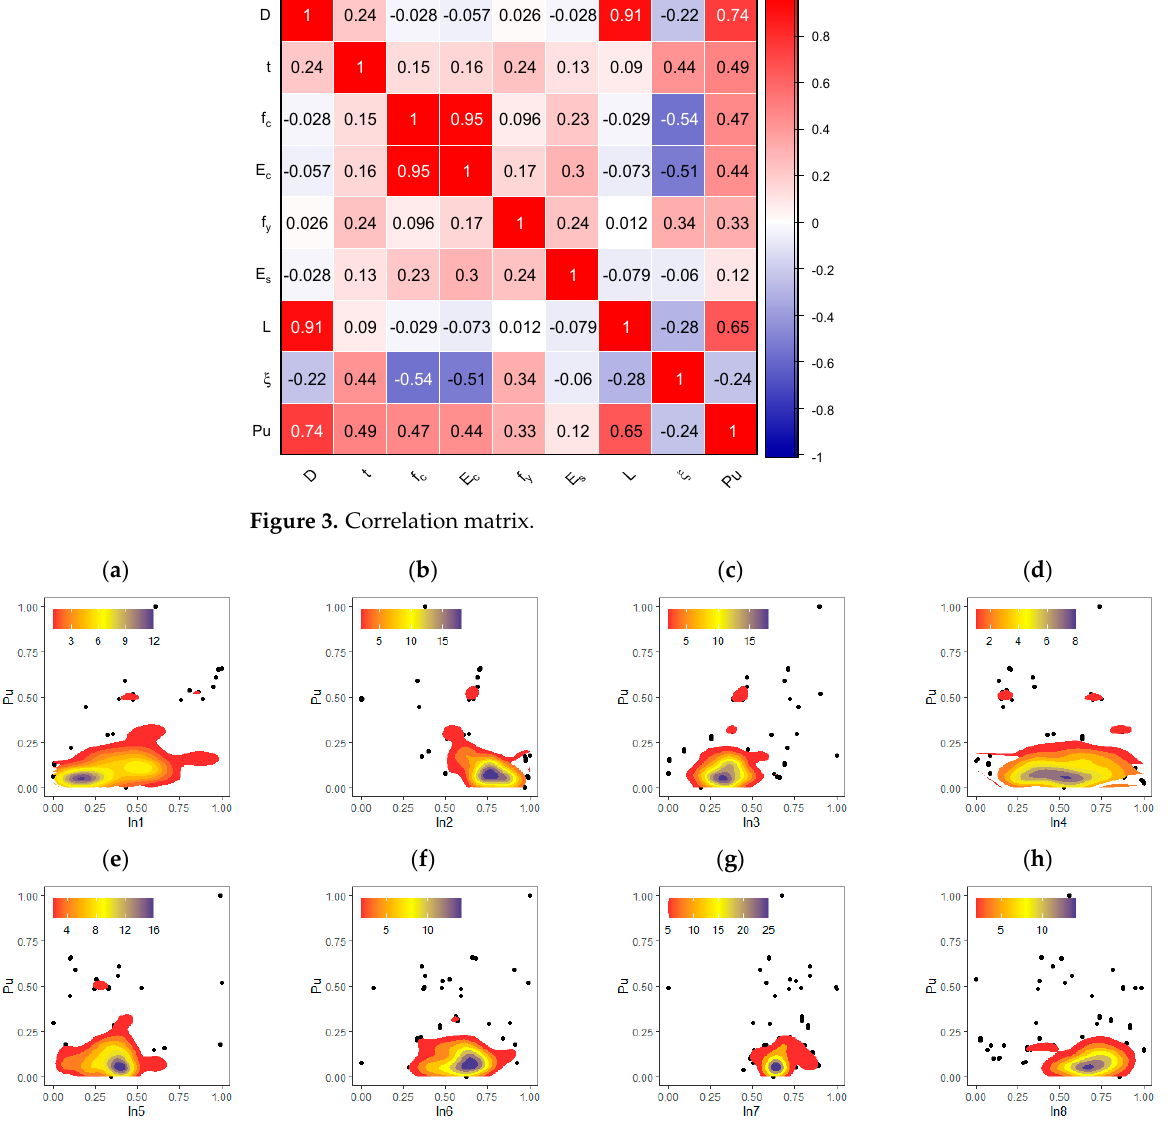
Figure 4. Scatter plot with 2-D density estimation between inputs parameters ( a – h ) and P u .